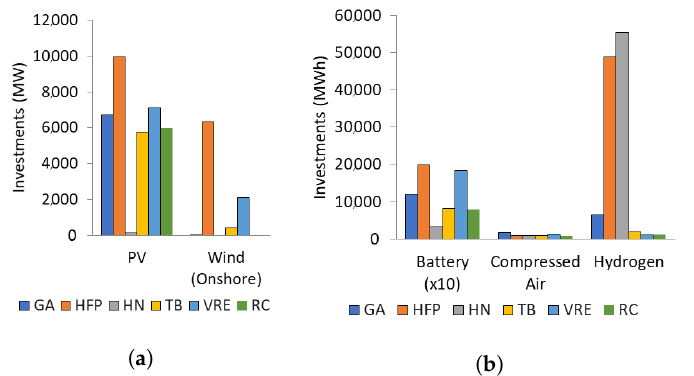
Figure 9. ( a ) 2030 investments in variable renewable generation with low operational detail. ( b ) 2030 investments in energy storage capacity with low operational